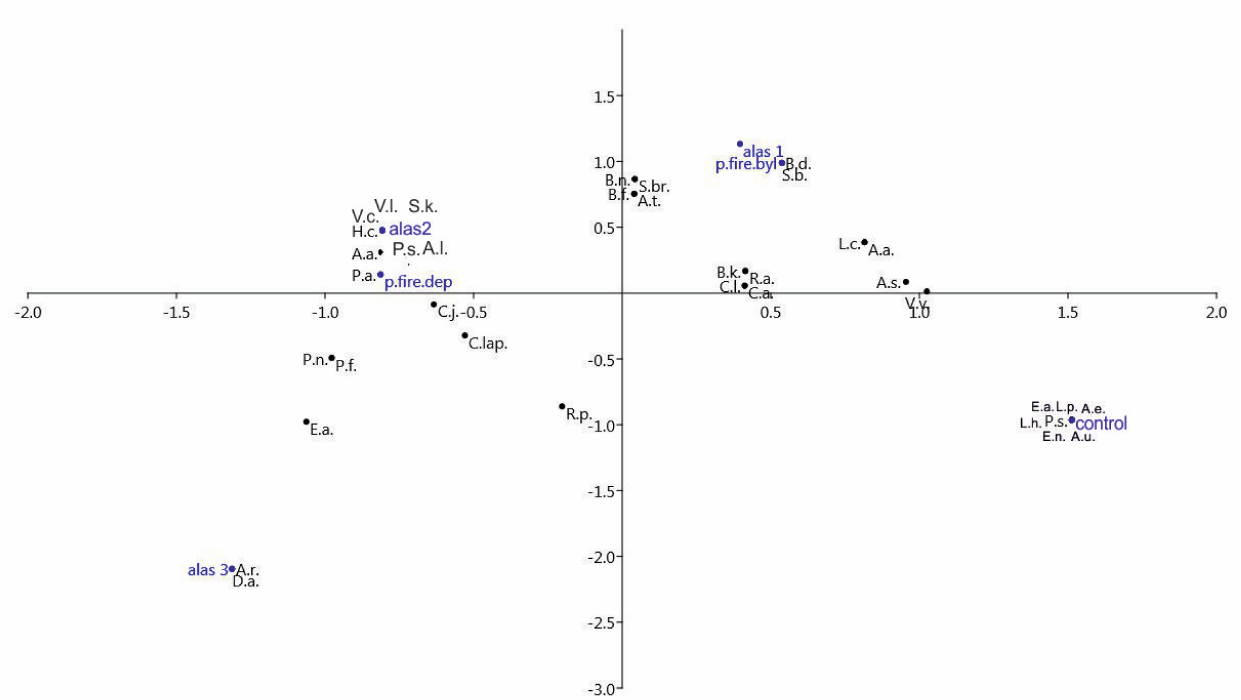
Figure 6. Scatter plot of correspondence analysis of plant species composition (control—larch forest, p.fire.byl.—young moss-vaccinium larch forest on the top of byllar, p.fire.dep.—sedge-reed herba- ceous vegetation in depression between byllars, alas 1—dwarf birch, alas 2—sedge meadow,